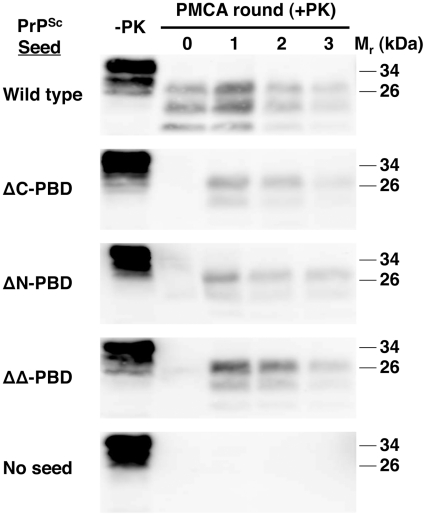
ΔPBD PrPSc molecules seeding wild-type brain homogenate sPMCA reactions.
In vitro-generated ΔC-PBD, ΔN-PBD, and ΔΔ-PBD PrPSc molecules were propagated by sPMCA for three rounds with wild-type mouse brain homogenate, containing wild-type PrPC substrate. Control reactions seeded with wild-type native RML prions and unseeded reactions were also tested. One sample of each reaction was not subjected to protease digestion (−PK), while all others were digested with 25 µg/mL proteinase K. PrP was detected by immunoblot (anti-PrP 6D11).